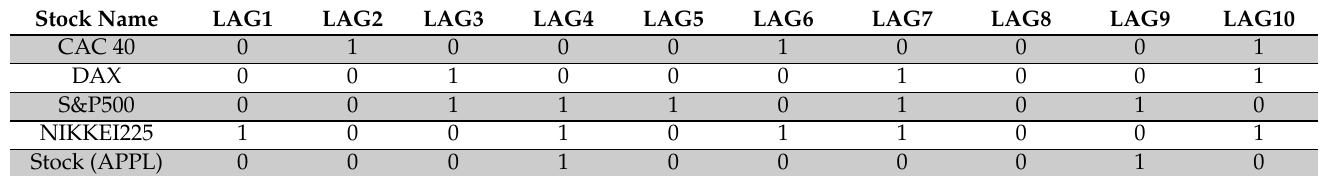
Table 4. The features of a one sample chromosome, represented as zeroes and ones.